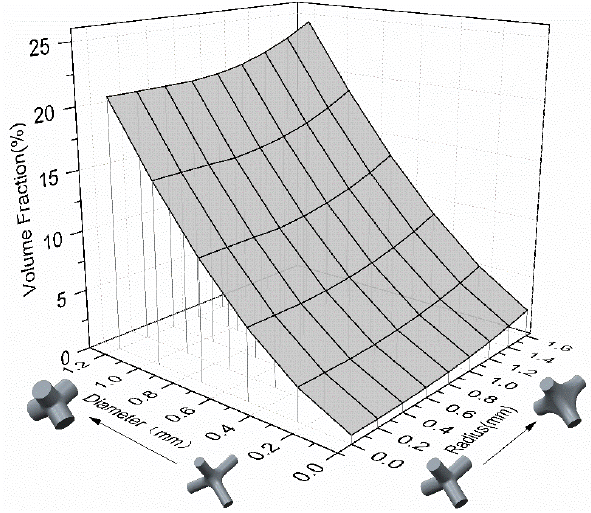
Figure 2. Value of volume fraction determined by rod diameter and optimized-radius.